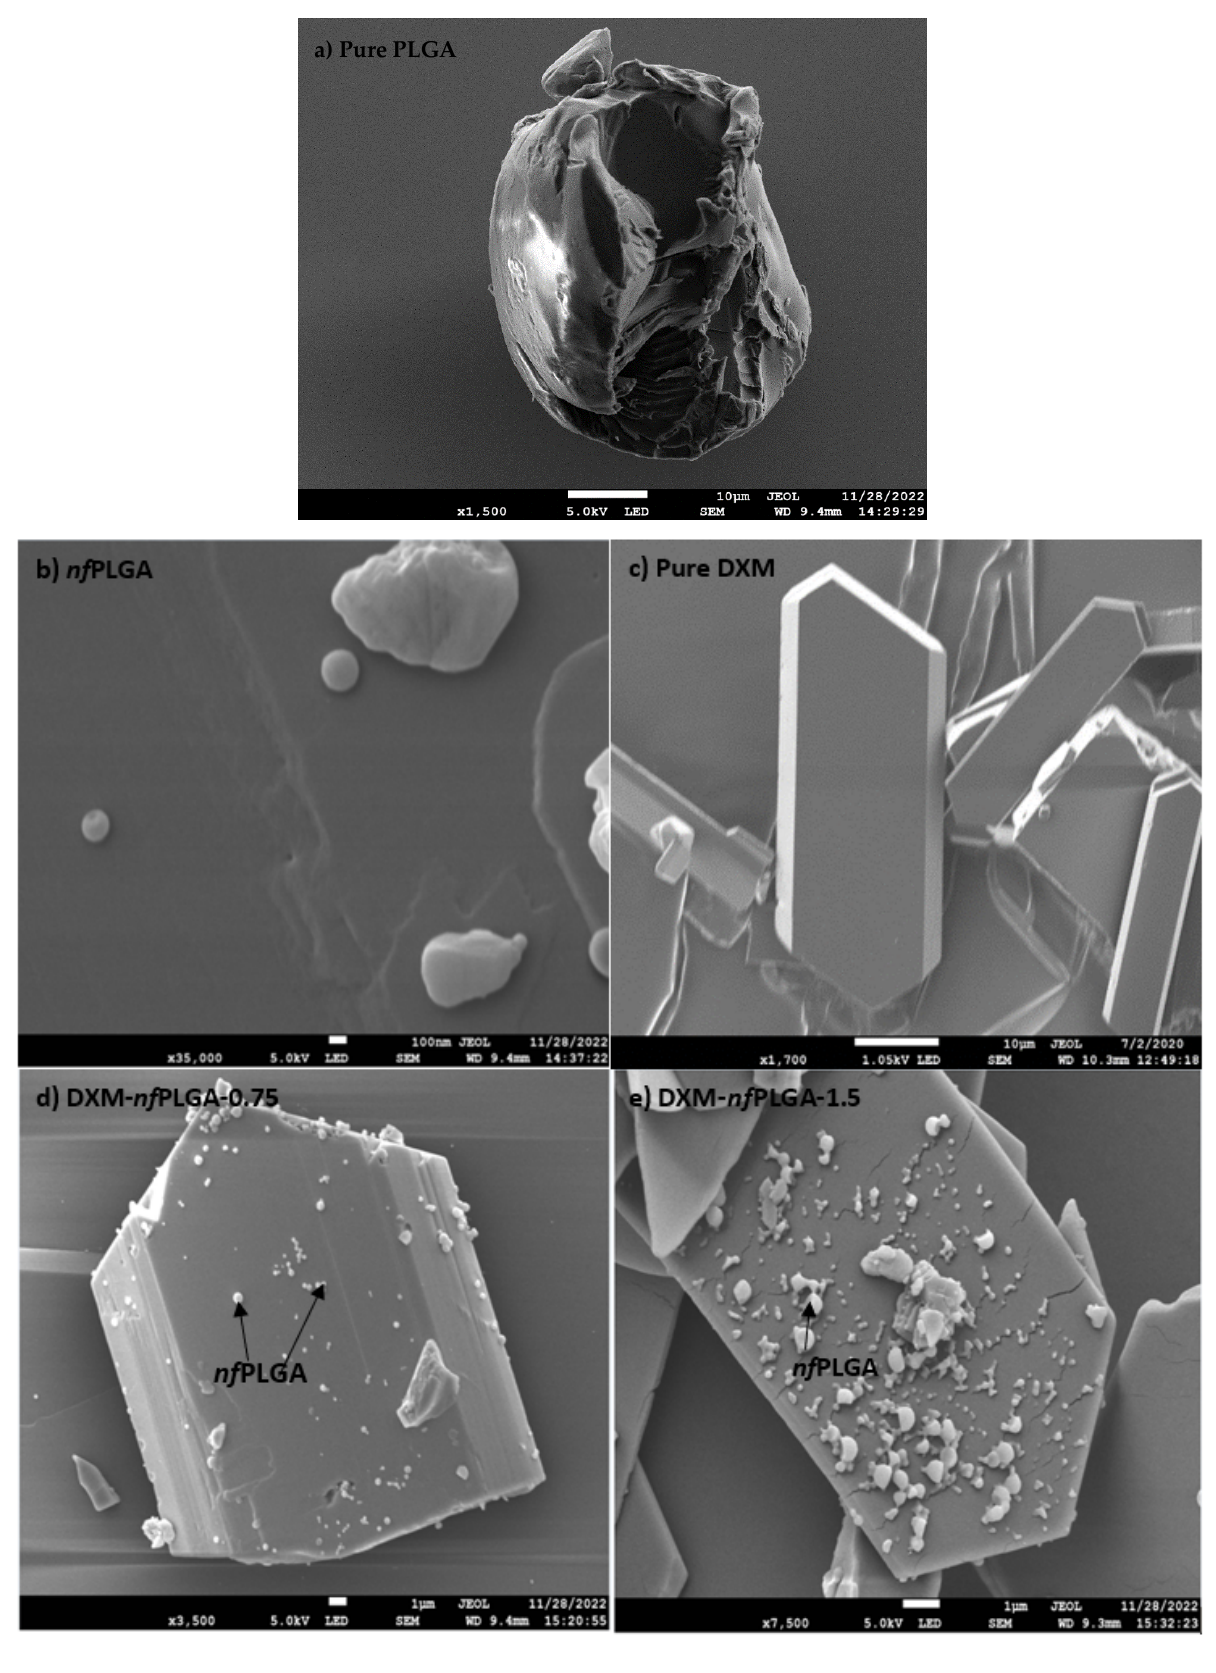
Figure 3. SEM of ( a ) pure PLGA, ( b ) nf PLGA, ( c ) pure dexamethasone, ( d , e ) DXM–nfPLGA